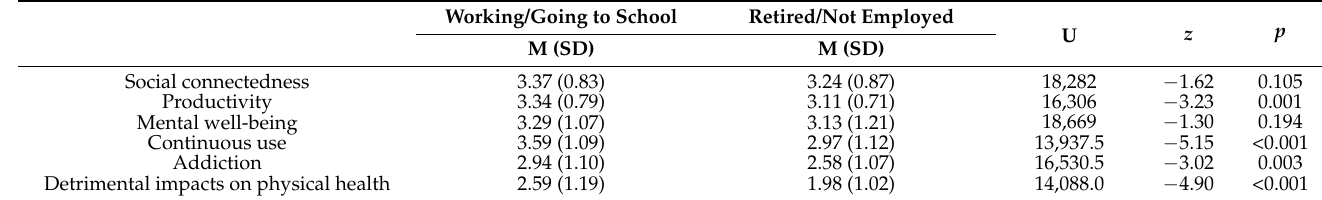
Table A6. Mobile Device Affinity and Usage since March 2020 Based on Occupation.